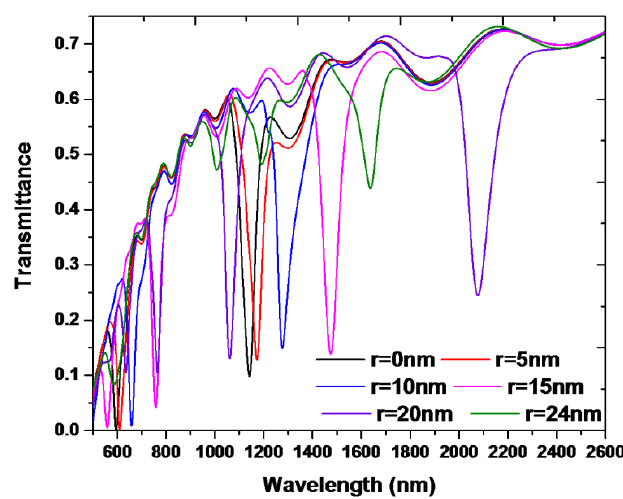
Figure 6. Transmittance spectra of the proposed band-stop filter with different silver nanorods radius of r = [0, 5, 10, 15, 20, 24] nm for the case with 16 silver nanorods in the nanoring, respectively. The other parameters are w =50, h =10, R =100 nm, N =16, and n =1.0, respectively. The transmittance spectrum of the proposed plasmonic band-stop filter versus different coupling length, h , is investigated, as shown in Figure 7a. In Figure 7a, the h values are varied from 5 to 30 nm in the step of 5 nm, while the other parameters are w =50, r =20 nm, R =100 nm, N =16, and n =1.0, respectively. The distance between the straight waveguide and the nanoring is also a significant factor influencing the transmittance properties and the hybrid mode with confinement. It can be found that the depth of transmittance dips reduce and shift to a shorter wavelength (i.e., blueshift) with the increasing of h . These phenomena are attributed to the change of the coupling length ( h ) between the nanoring and straight waveguide. It indicates that the λ res can be manipulated by varying the coupling length between the straight waveguide and the nanoring, which can originate from the perturbation of local SPPs mode’s n eff in the coupling region [35]. Figure 7b shows the normalized power flow versus positions of the straight waveguide along the x -axis (at y=0) in the range of −1500 to 1500 nm at different coupling length, h . As seen in Figure 7b, the trend of power flow decreases abruptly as the positions of x >0, indicating that the nanoring containing silver nanorods can function as a plasmonic band-stop filter. The best result is for h = 10 nm.